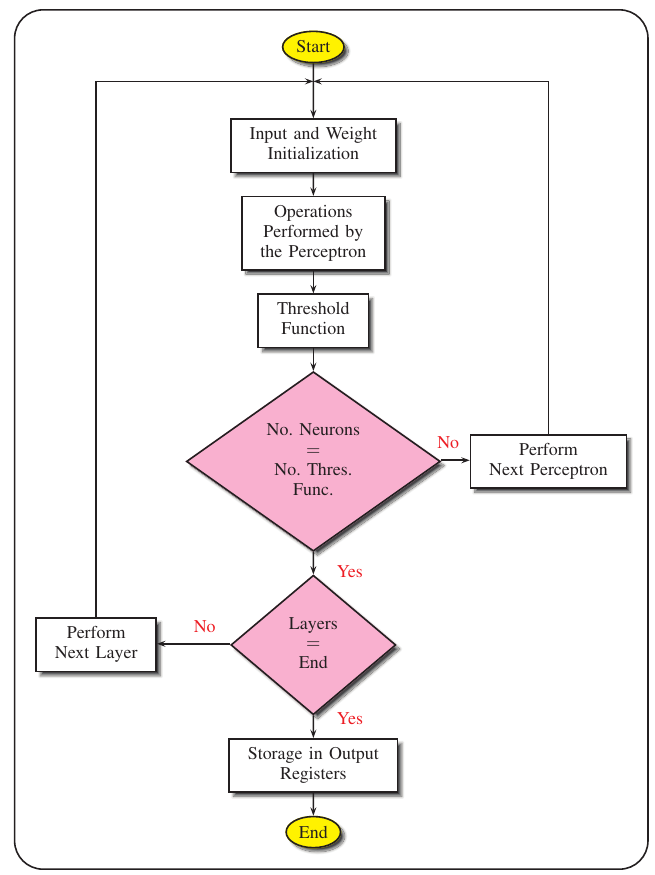
Figure 6. FSM designed flow diagram for the